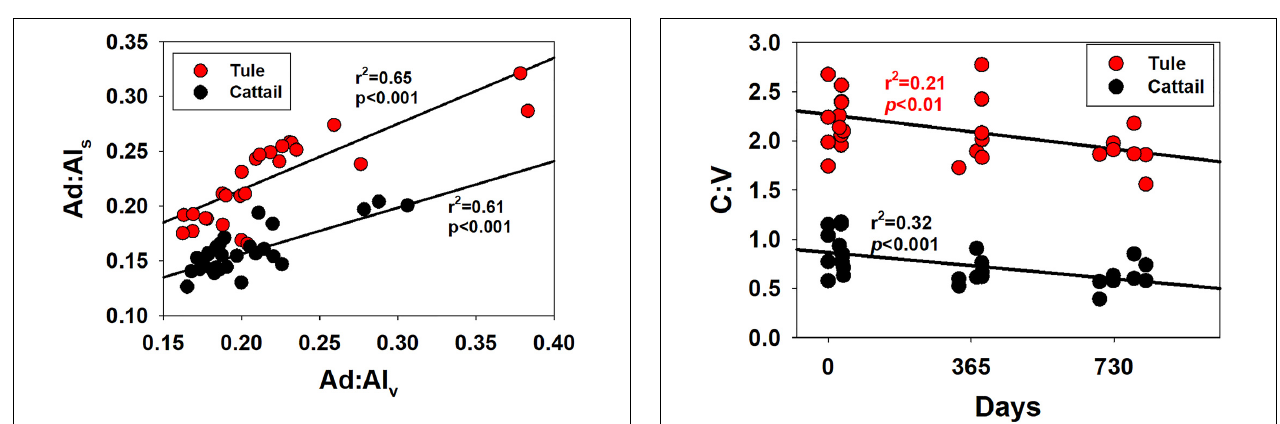
FIGURE 7 | Ratios of the sum of the cinnamyl phenols, C, and the sum of the vanillyl phenols, V, versus time for all samples, plotted separately for tule and